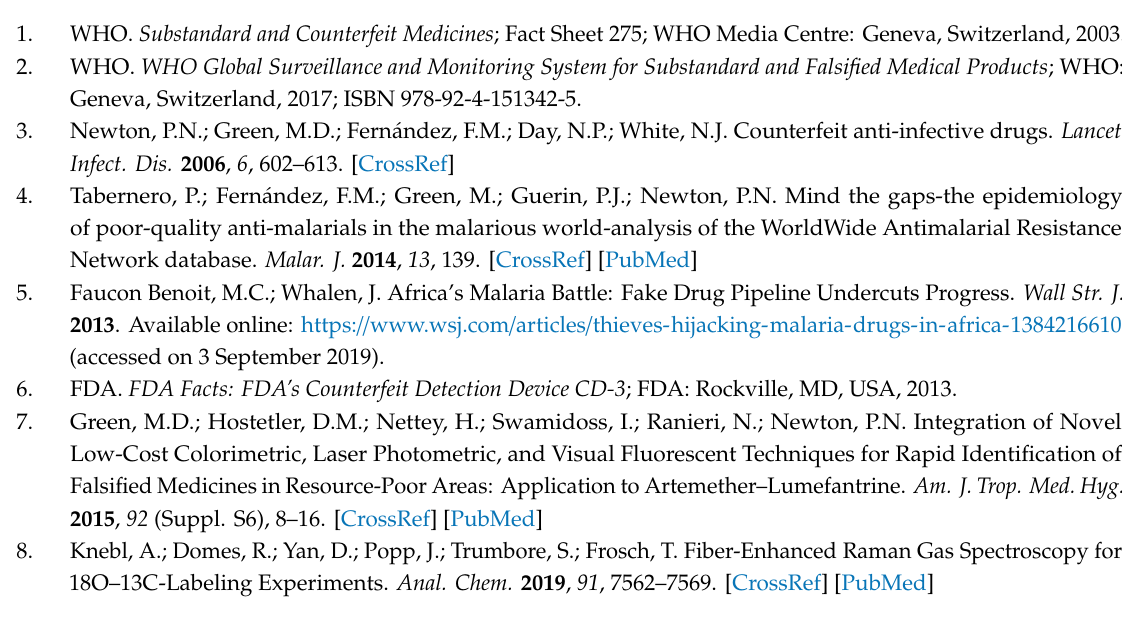
Figure S1: Comparison of the calculated Raman spectra (DFT) with the experimentally acquired FT-Raman spectra of the active ingredients lumefantrine and artemether. Figure S2: Exemplary visualization of the spatial distribution of the lumefantrine concentration along one hyperspectral image in the model tablet